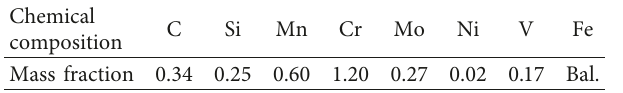
Table 1: Composition in mass % of 35CrMoV steel employed.